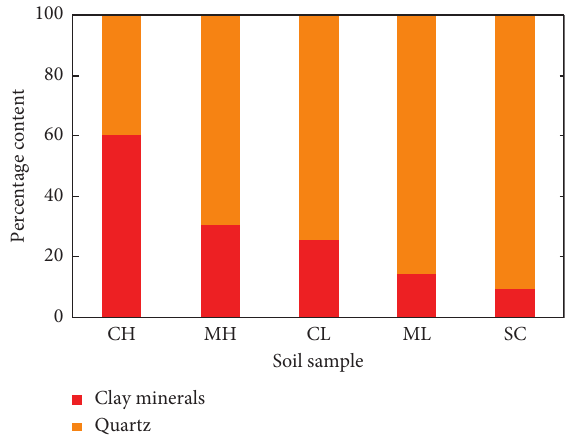
Figure 5: Contents of quartz and clay minerals in different soils. Table 2: Mineral compositions of different soil samples.